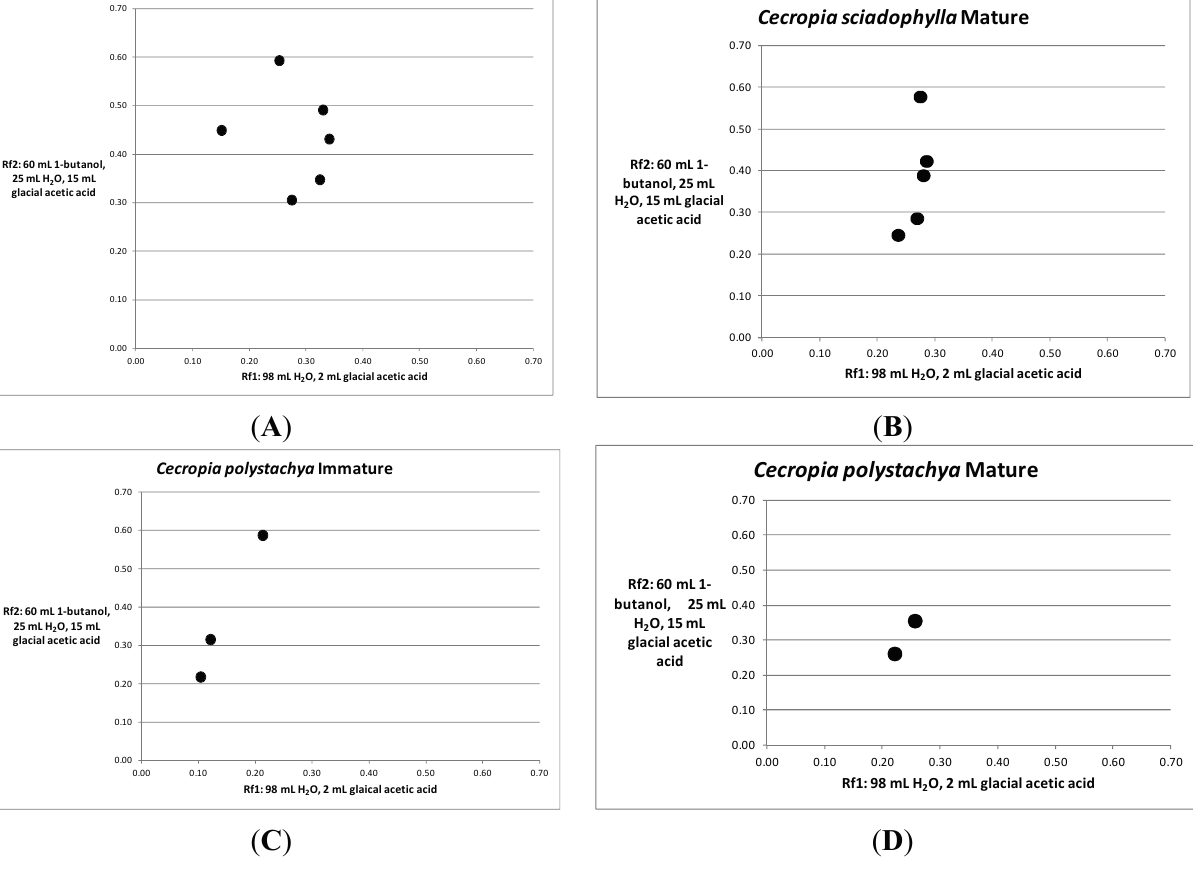
Figure 5. Two dimensional TLC of thiolyzed proanthocyanidins extracted from Cecropia leaves. ( A ) Cecropia sciadophylla immature leaves. ( B ) Cecropia sciadophylla mature leaves. ( C ) Cecropia polystachya immature leaves. ( D ) Cecropia polystachya mature